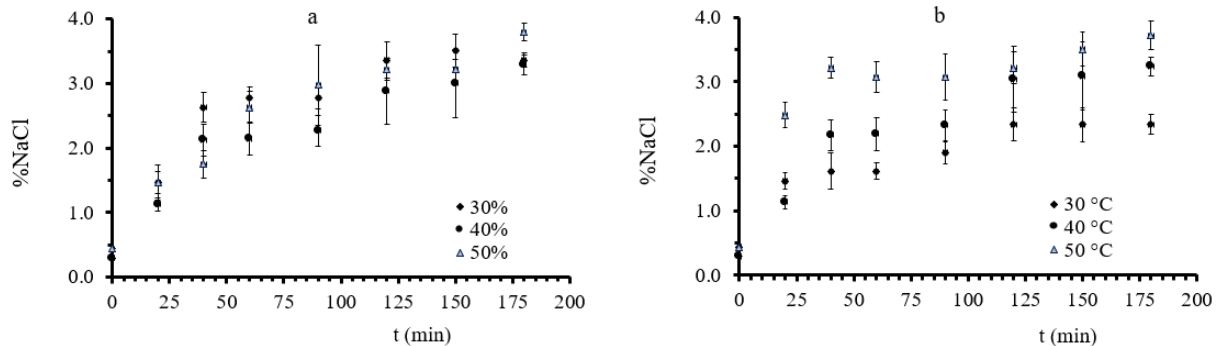
Figure 5. ( a ): %NaCl during osmotic dehydration at 40 ◦ C, at all three different glycerol concentration and ( b ) %NaCl during osmotic dehydration at 40% glycerol concentration, at all three different temperatures. Points represent average values, and error bars represent the standard deviation, as calculated from the three measurements.